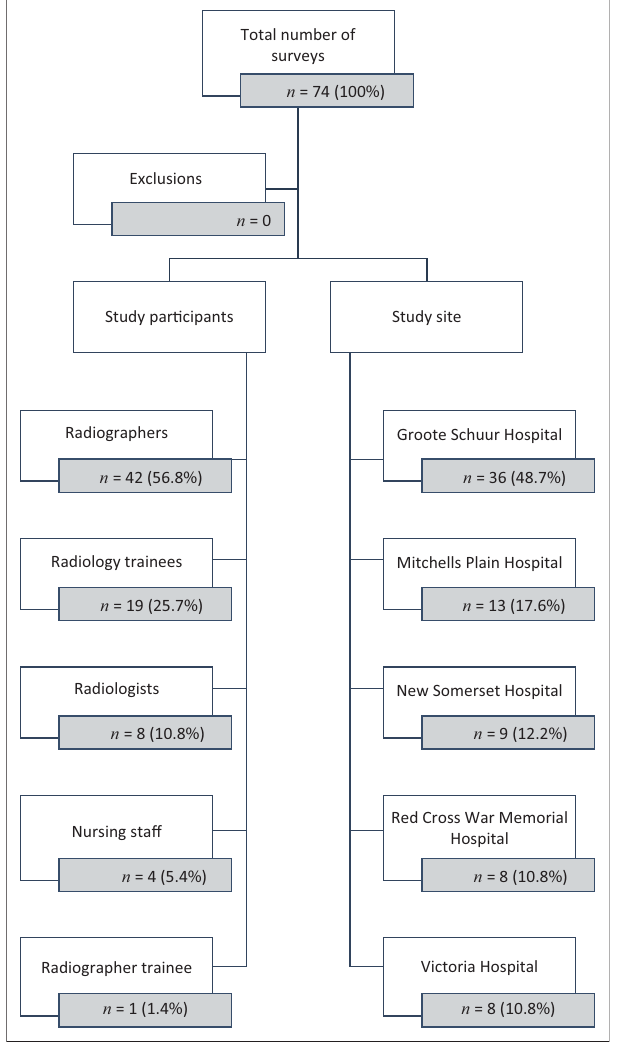
FIGURE 1: Breakdown of respondents’ TABLE 1: Level of working experience in the imaging department of various study participant groups. Experience level